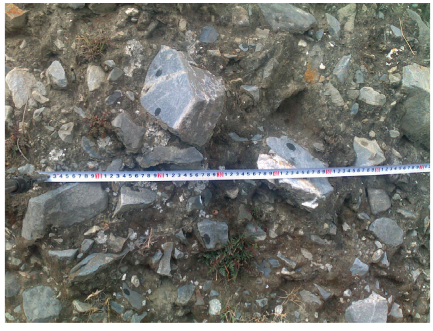
Figure 2: Soil-rock mixture